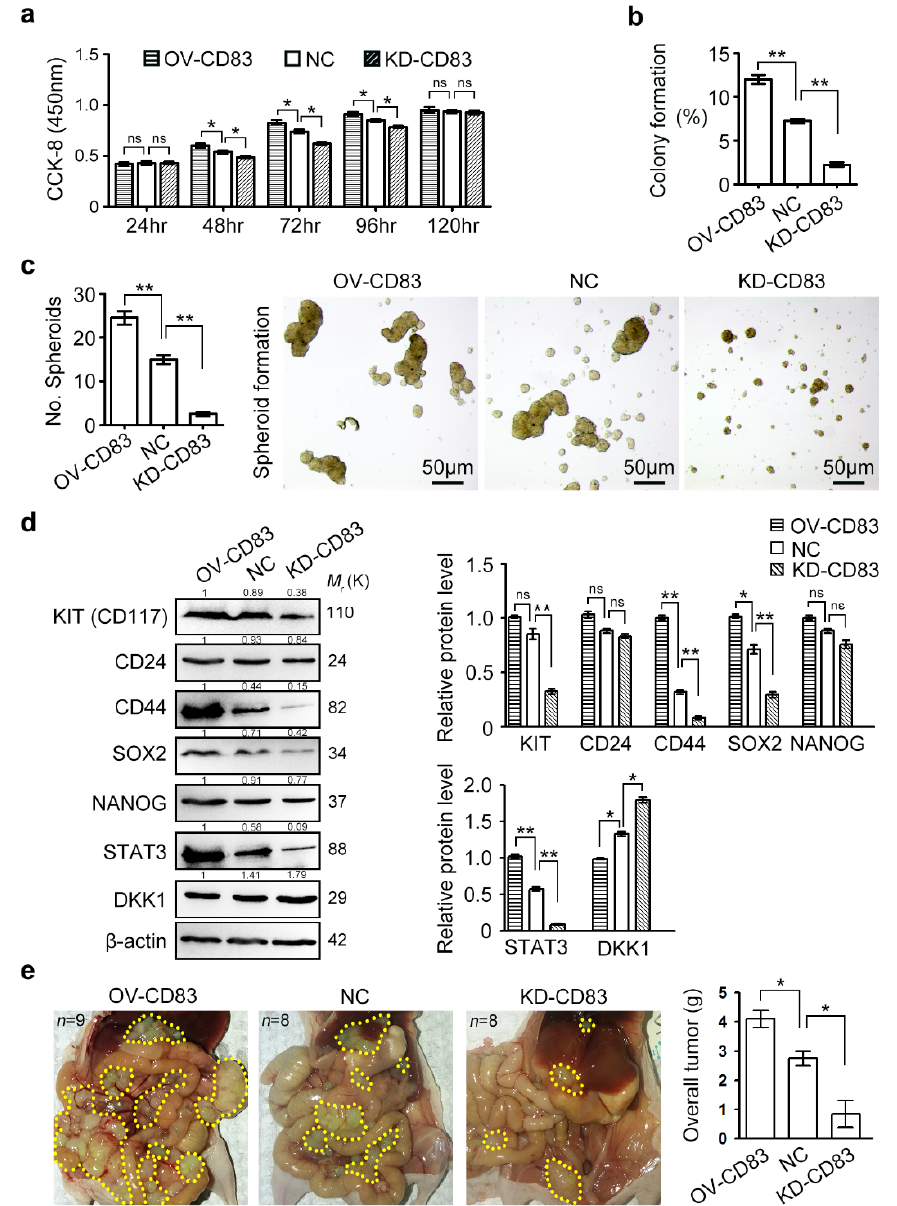
Figure 2. CD83 promoted growth proliferation, spheroid formation, and in vivo tumor growth of ovarian cancer cells. ( a ) SKOV3 cell proliferation was significantly attenuated by CD83 knockdown, whereas CD83 overexpression significantly stimulated the proliferation, as revealed by Cell Counting Kit-8 (CCK-8) assay. ( b ) Colony formation of SKOV3 cells (500 cells per 60 mm dish) was significantly promoted by enforced expression of CD83. ( c ) The number of spheroids derived from SKOV3 cells, which are cultured onto ultra-low attachment plates in cancer stem cell culture medium. Scale bar, 50 µ m. ( d ) Expression of stemness factors, STAT3, and DKK1 identified by Western blotting. The uncropped western blots of Figure 2d in the Figure S10. ( e ) Intraperitoneal injection of SKOV3 cells (1 × 10 6 ) into nude mice. The total tumor weights for CD83-OV groups ( n = 9) were significantly higher than that for the control groups ( n = 8) and CD83-KD groups ( n = 8). The di ff erences between NC and OV, as well as NC and KD, were presented as the mean ± SEM; Student’s t -test; * p < 0.05, ** p < 0.01, ‘ns’ means not